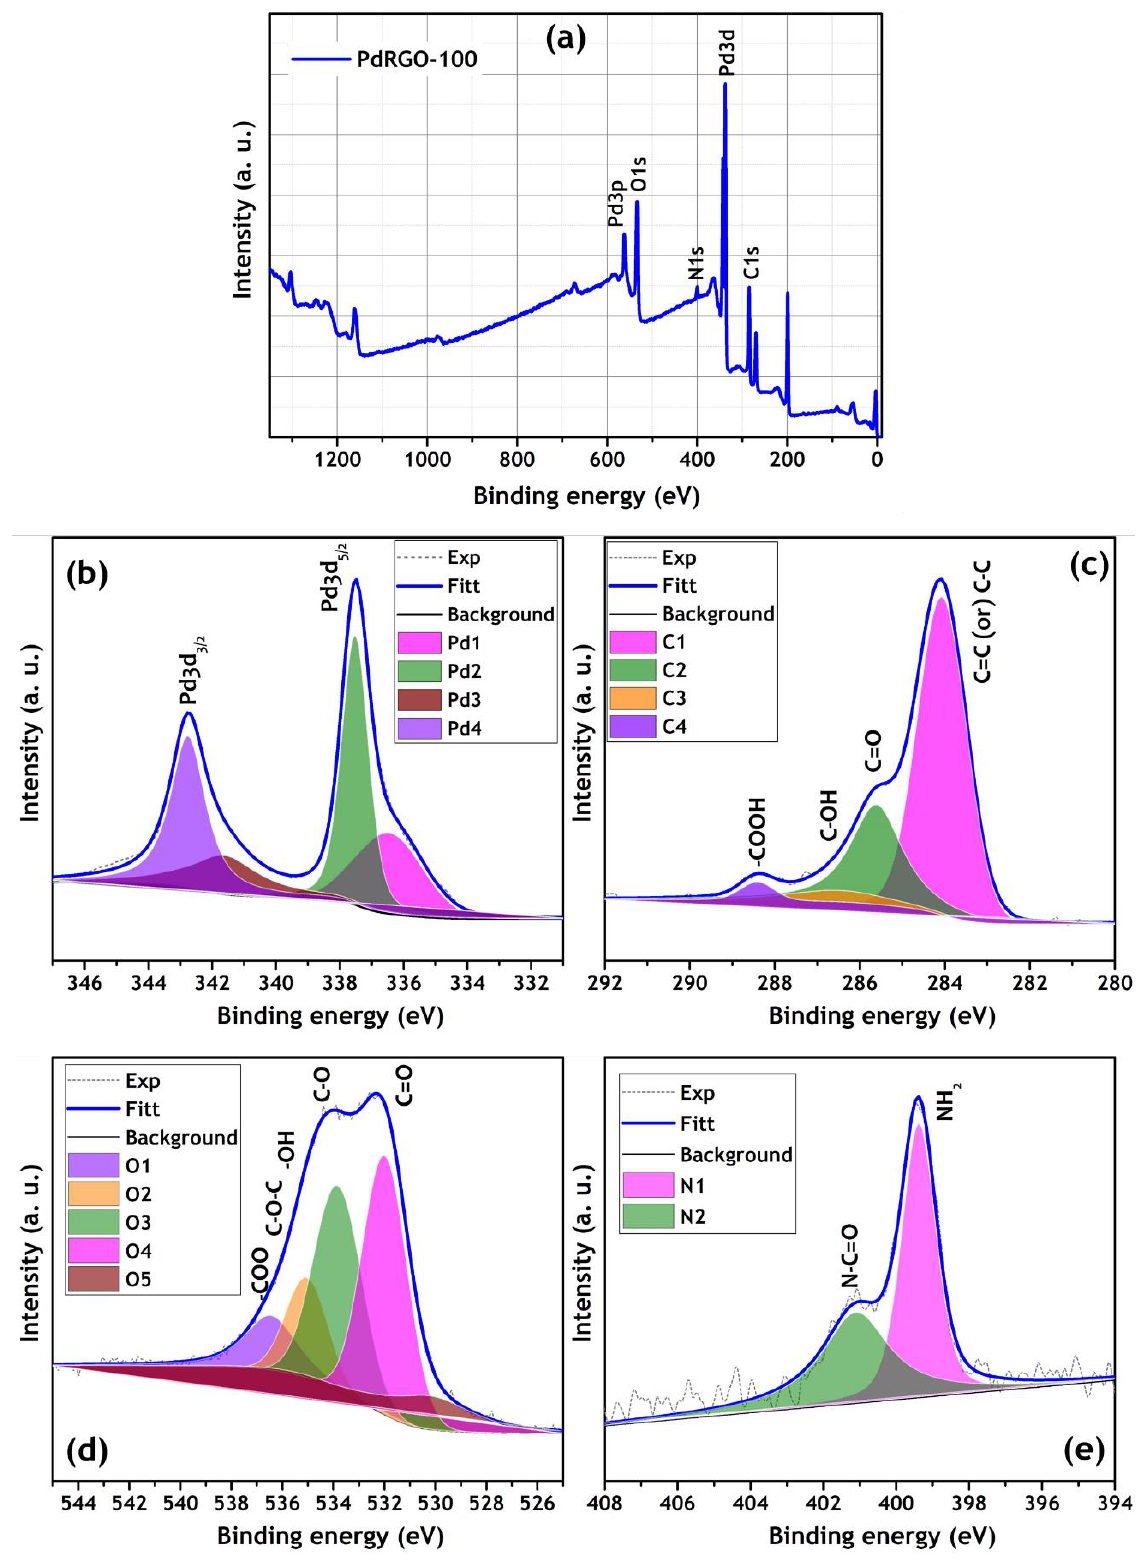
Figure 5. XPS spectra of RGO-PN100 for ( a ) survey scan, ( b ) palladium, ( c ) carbon, ( d ) oxygen, and ( e ) nitrogen elements.